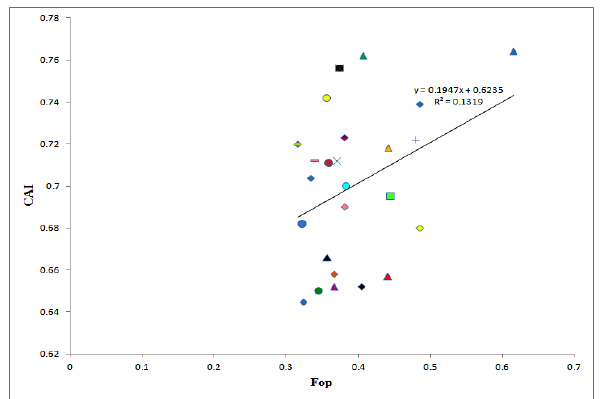
Fig. 5. Relation between the frequency of optimal codon usage and gene